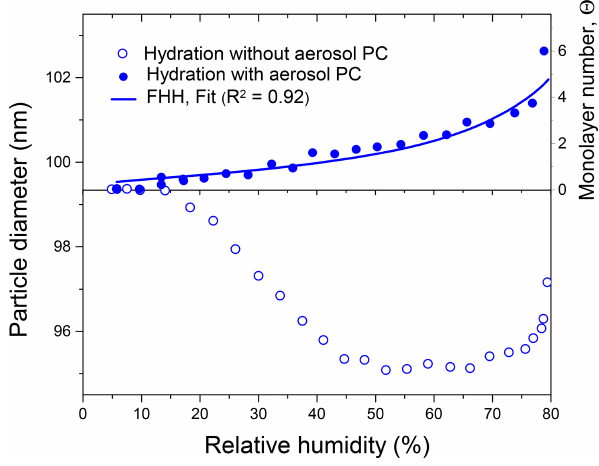
Figure 7. Mobility equivalent diameters of ammonium sulfate par- ticles observed in hydration experiments with and without precon- ditioning and an equivalent number of monomolecular layers. (cid:50) was calculated from Eq. (27) assuming that D b, H&D , min = D m , s = 99 . 35 ± 0 . 03nm, obtained with aerosol particle preconditioning. The line is the Köhler model fit (Eq. 6) with water activity from the FHH adsorption isotherm (Eq.